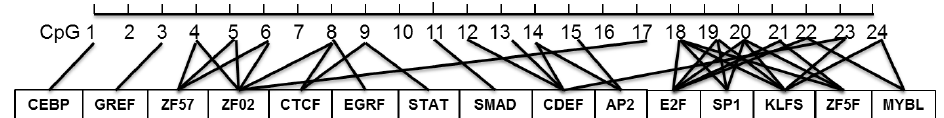
Figure 5. Prediction of the possible binding transcription factors for each CpG-dinucleotide locus in the CpG island within the goat PITX1